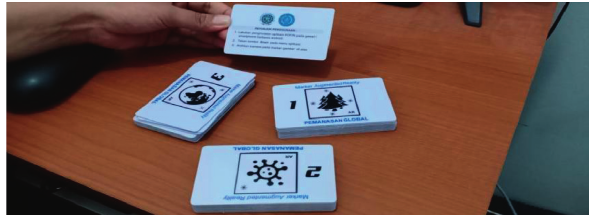
Figure 9: Products of AR card markers.